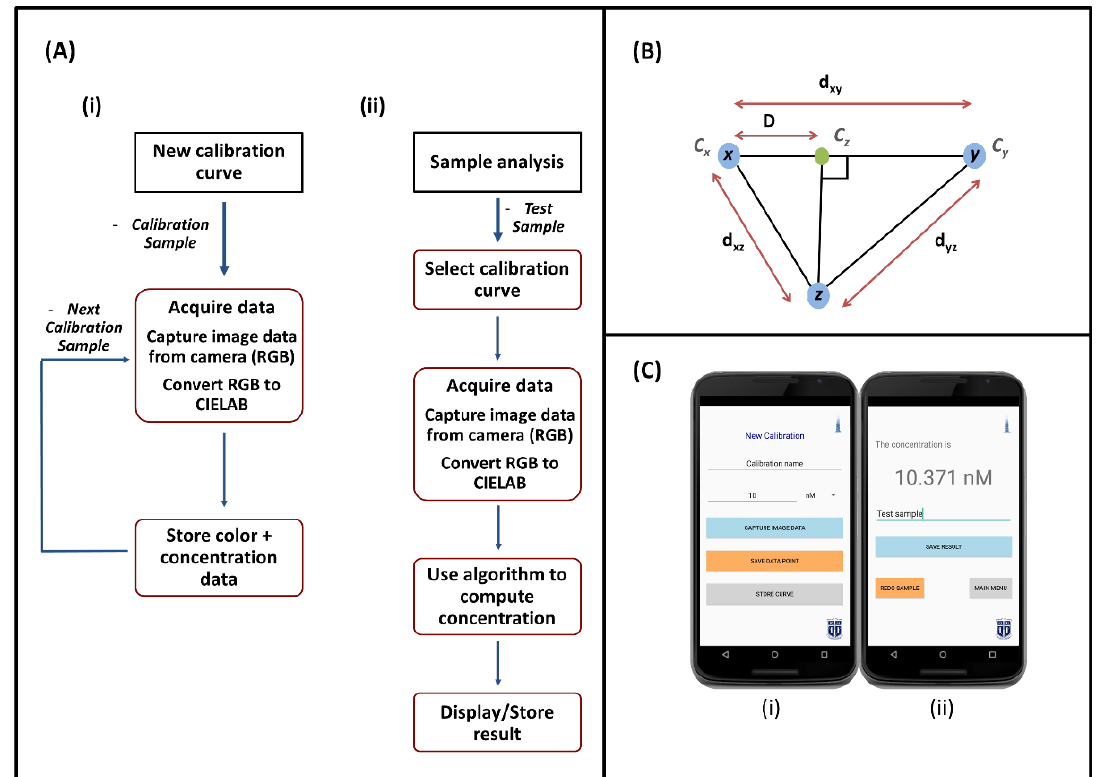
Figure 2. ( A ) Schematic diagram of the process flow for ( i ) creating a new calibration curve, and ( ii ) analyzing a test sample using the Krometriks app. ( B ) 2-D representation of the geometric relationship between x , y , and z , where z is the test sample point, x is the calibration points closest to z , and y is the calibration point on either side of x in a sorted list of calibration points that are closest to z . The concentration C z is linearly interpolated on the line between C x and C y . ( C ) Screenshots from the Krometriks app showing the page: ( i ) for adding a new data point while creating a new calibration curve, ( ii ) displaying the result-estimated concentration value of test sample.